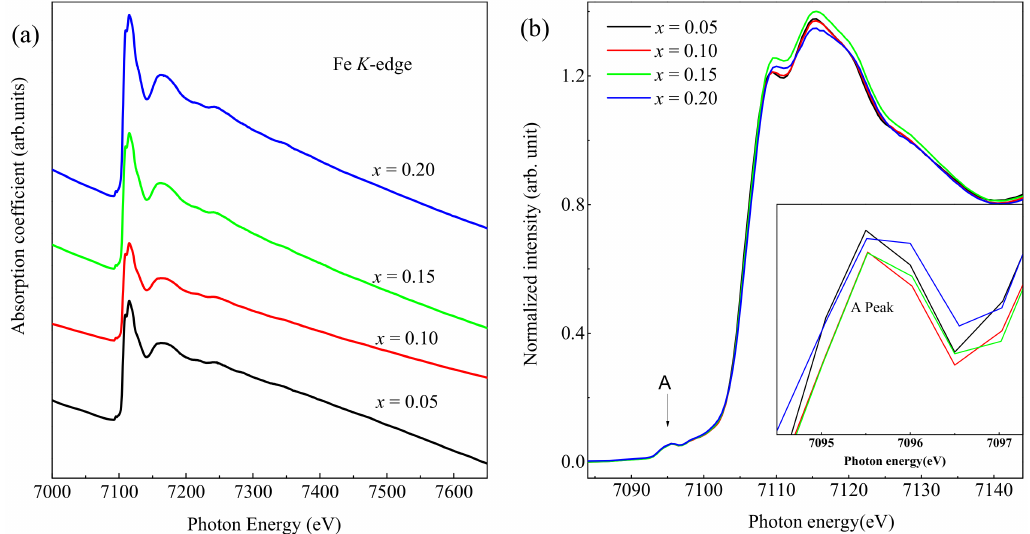
Figure 5. Raw data for the XAFS spectra ( a ) and Fe K -edge XANES spectra ( b ) of La x Bi 1 − x Fe 0.95 Co 0.05 O 3 .